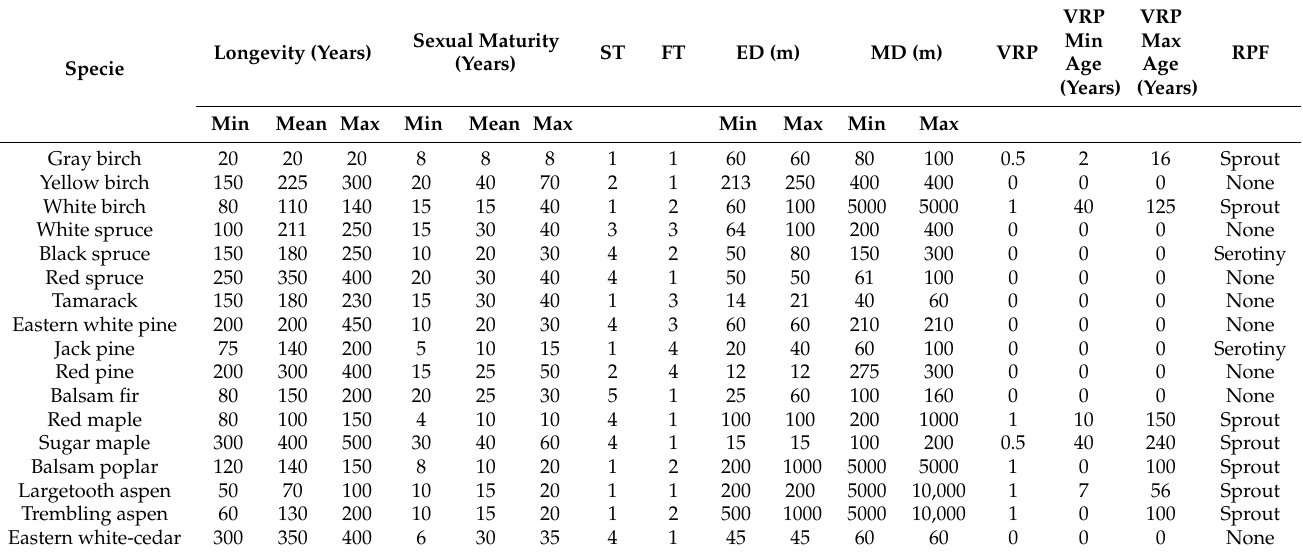
Table 2. Life-history attributes for the 17 species included in this